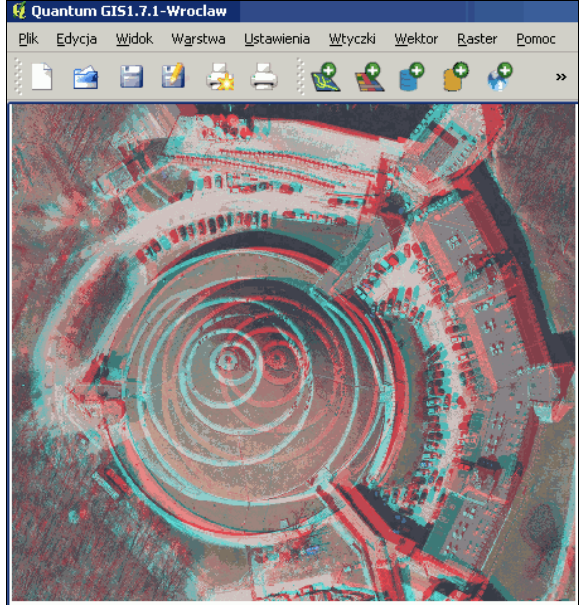
Fig. 3. Example visualisation of stereo orthophoto in QuantumGIS environment (courtesy of MGGP AERO Company, Tarnow,